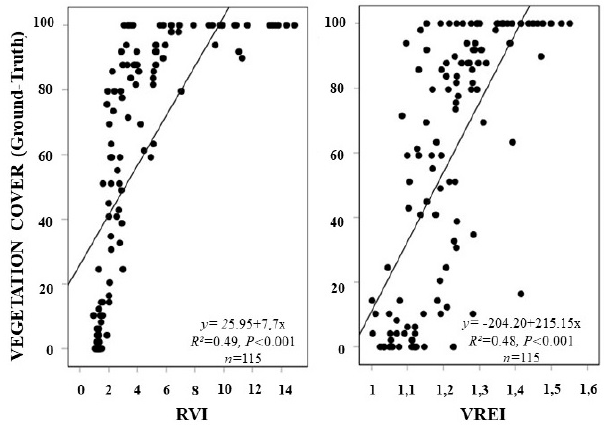
Figure 6. Scatter diagrams and regression curves of the relation between vegetation cover (Ground- Truth) and VIs.